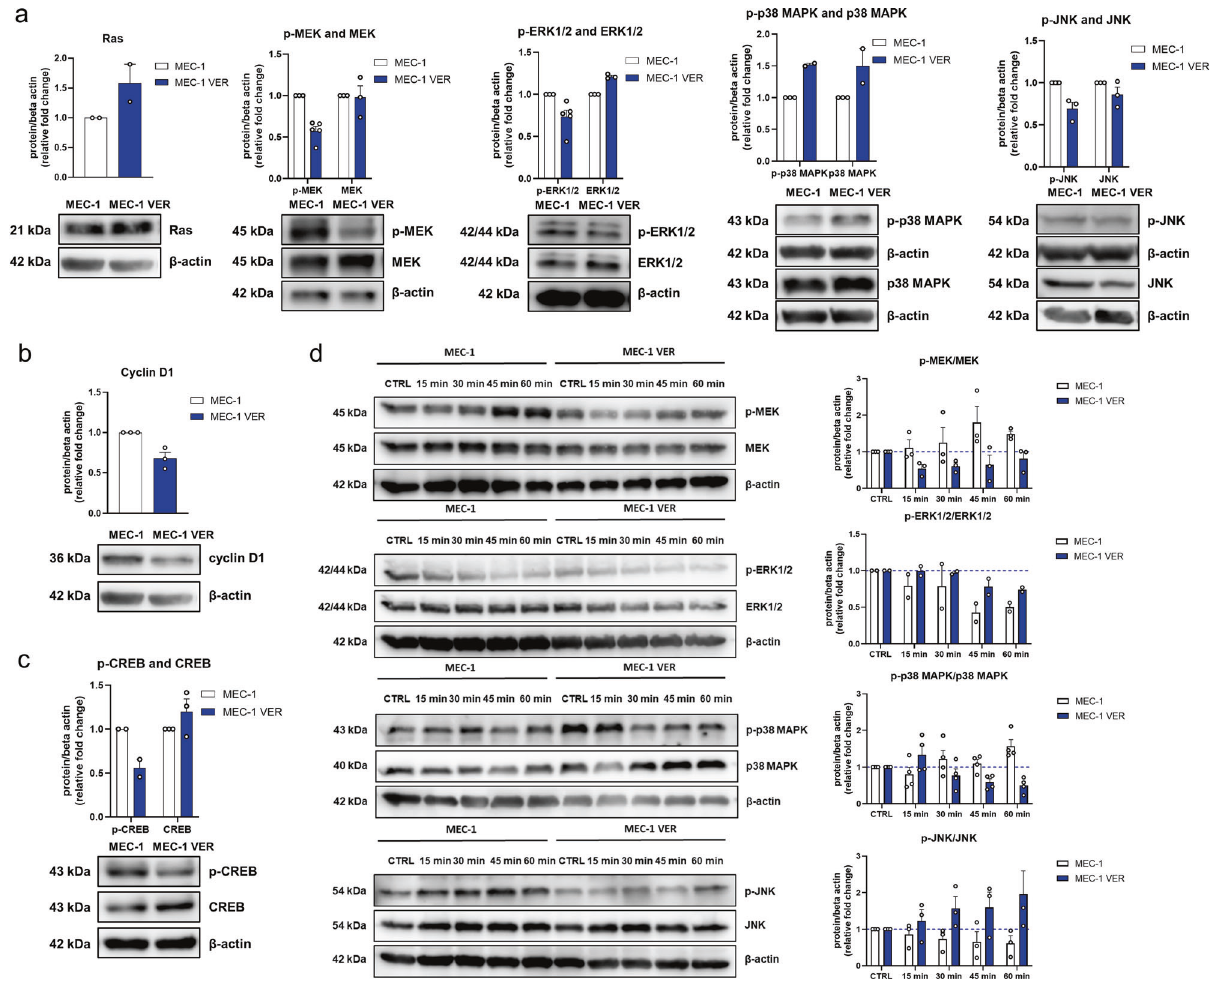
Fig. 6 Differential expression of MAPKs and their downstream effectors in MEC-1 and MEC-1 VER cells. a – c Expression levels of Ras, p-MEK, MEK, p-ERK1/2, ERK 1/2, p-p38 MAPK, p38 MAPK, p-JNK, JNK ( a ), cyclin D1 ( b ), and p-CREB and CREB ( c ) in MEC-1 and MEC-1 VER cells under basal conditions; d The expression levels of p-MEK, MEK, p-ERK1/2, ERK1/2, p-p38 MAPK, p38 MAPK, and p-JNK, JNK over time following treatment of MEC-1 and MEC-1 VER cells with 10 µM venetoclax. Data are means ± SEM of ≥ two independent experiments. Representative immunoblots are also